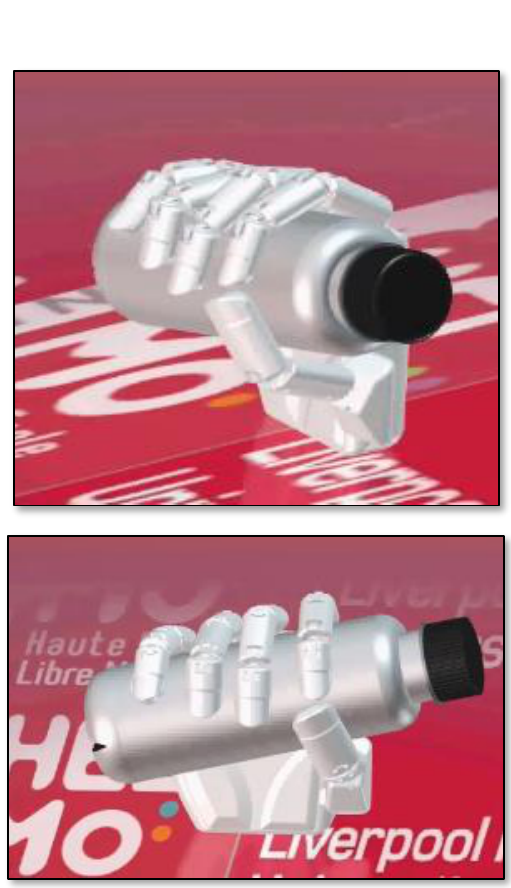
Figure 5. The robotic hand human-like grasping